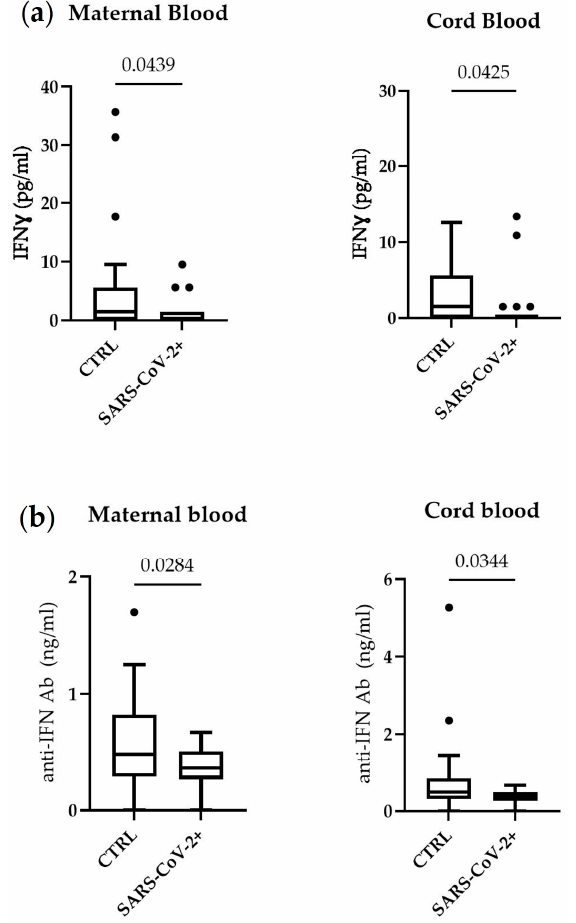
Figure 2. Serum IFN- γ in maternal blood and cord blood ( a ) and serum IFN antibodies ( b ). Box plots denote median and 25th to 75th percentiles (boxes) and Tukey whiskers. The p value was evaluated using unpaired t -test and Mann–Whitney test.